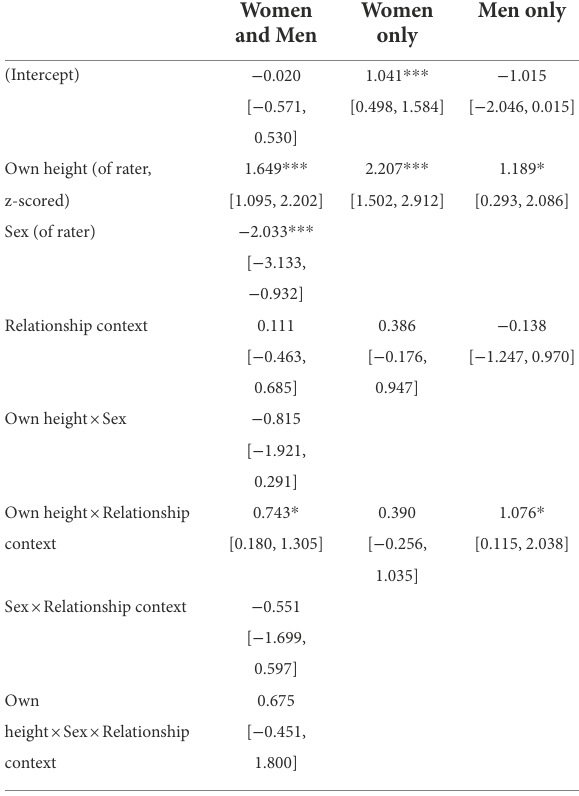
TABLE 4 Model 2: Linear mixed effects model testing for differences in assortative preferences for mate height as a function of a short- term versus long-term relationship context, nesting participants by self-reported